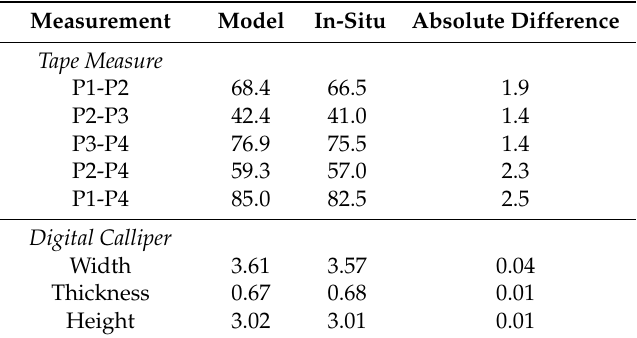
Table 3. Comparison between measurements from the underwater SfM-MVS model and tape measure distances and digital calliper measurements of the dimensions of the hexagonal locknut targets. P1–P4 refer to the locations of the locknuts in Figure A1. Measurements are in